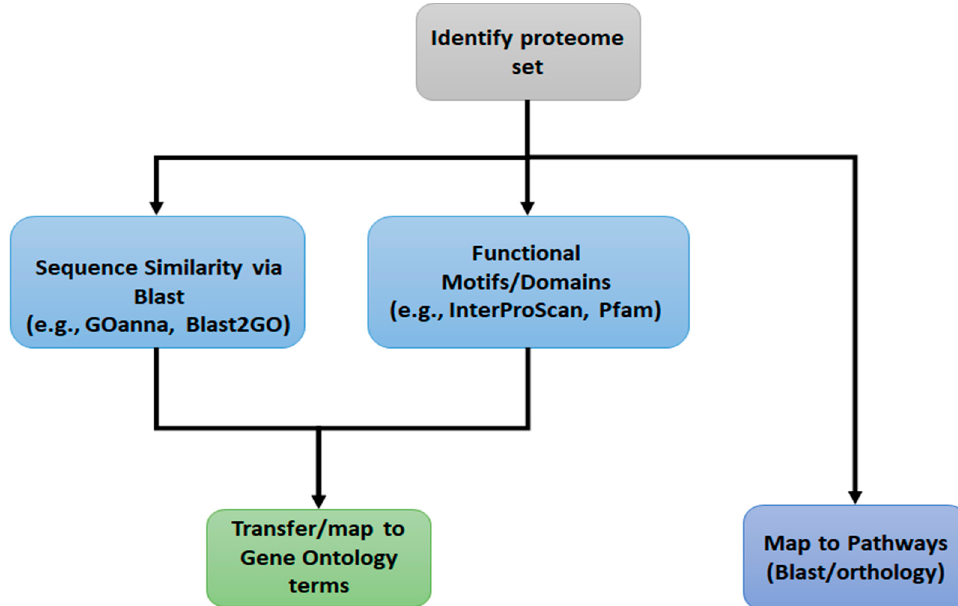
Figure 1. Generalized functional annotation workflow. The general approach for functional anno- tation is to combine GO annotations transferred based on sequence homology (e.g., BLAST) with information about functional motifs (e.g., derived from resources, such as PFAM). Gene products are mapped to metabolic and signaling pathways based upon sequence homology or orthology.